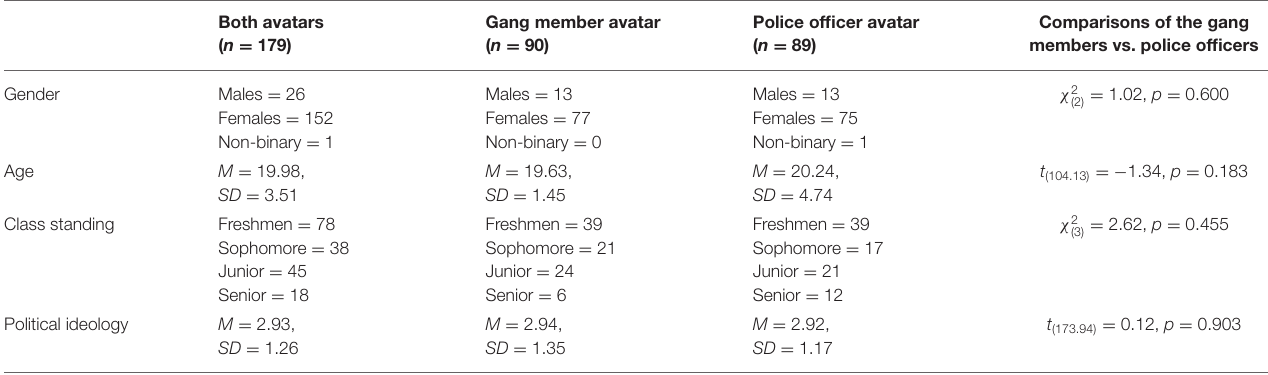
TABLE 1 | Descriptive statistics and statistical comparisons of the avatar groups.